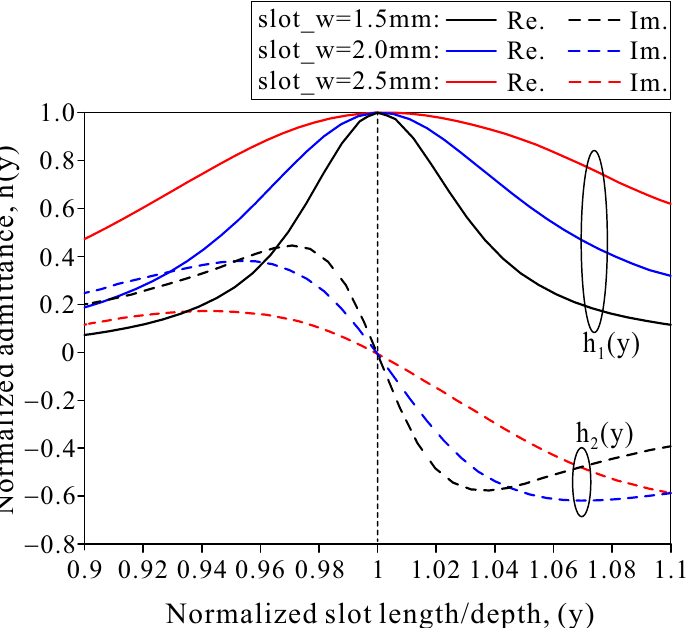
Figure 5. Effects of the slot width versus normalized admittance at the resonant frequency of 9.8